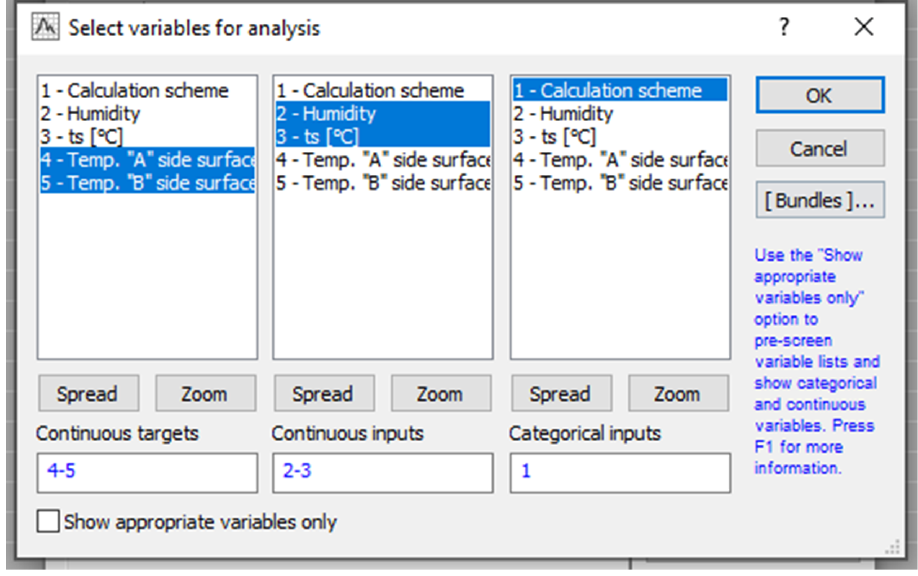
Figure 11. Selection of the input and output vector.